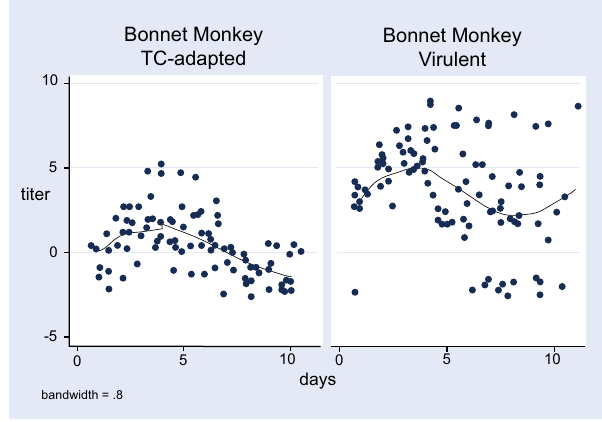
Figure 1. Viremia titers (log LD50) with TC-adapted and virulent KFDV in Langur monkeys.